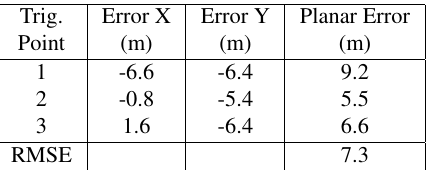
Table 8. The errors of CPs for the direct method applied to 2 corrected maps in Thassos test